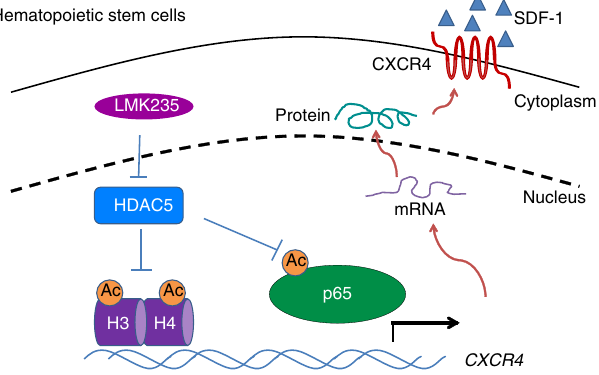
Fig. 9 Model for the role of HDAC5 in regulating CXCR4 expression in human HSC/HPCs. HDAC5 inhibition by LMK235 results in enhanced acetylation of histone 3 on lysine 9 and histone 4 on lysine 16, as well as p65 acetylation. Acetylation of histone facilitates chromatin remodeling, whereas acetylation of p65 enhances its transcriptional activity. Acetylated p65 binds to CXCR4 promoter region and induces higher expression of CXCR4 and thus enhances HSC/HPC homing and added to the bottom well. Cells were suspended at 1× 10 5 cells/100 μ L in IMDM